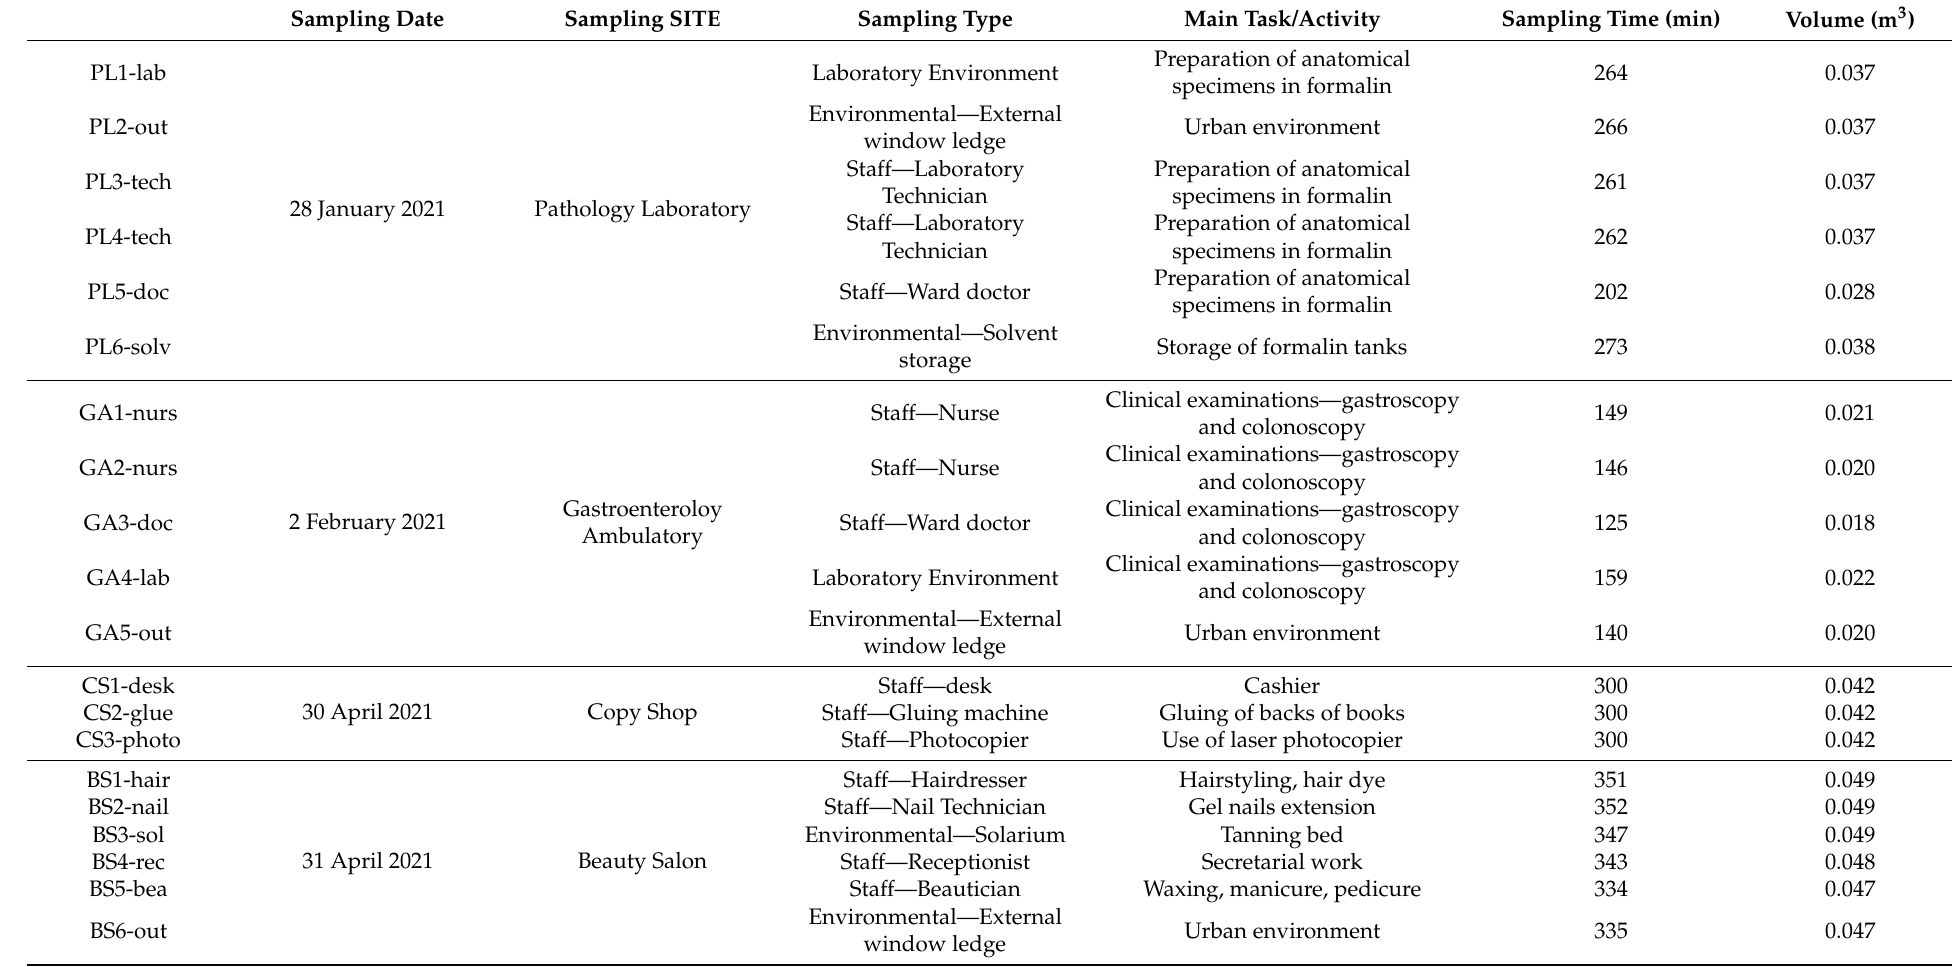
Table 1. Specifications of the sampling sites and